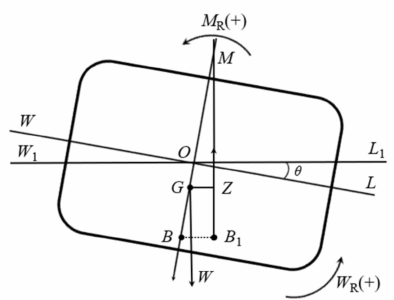
Figure 1. The diagram effect of restoring torque [20].